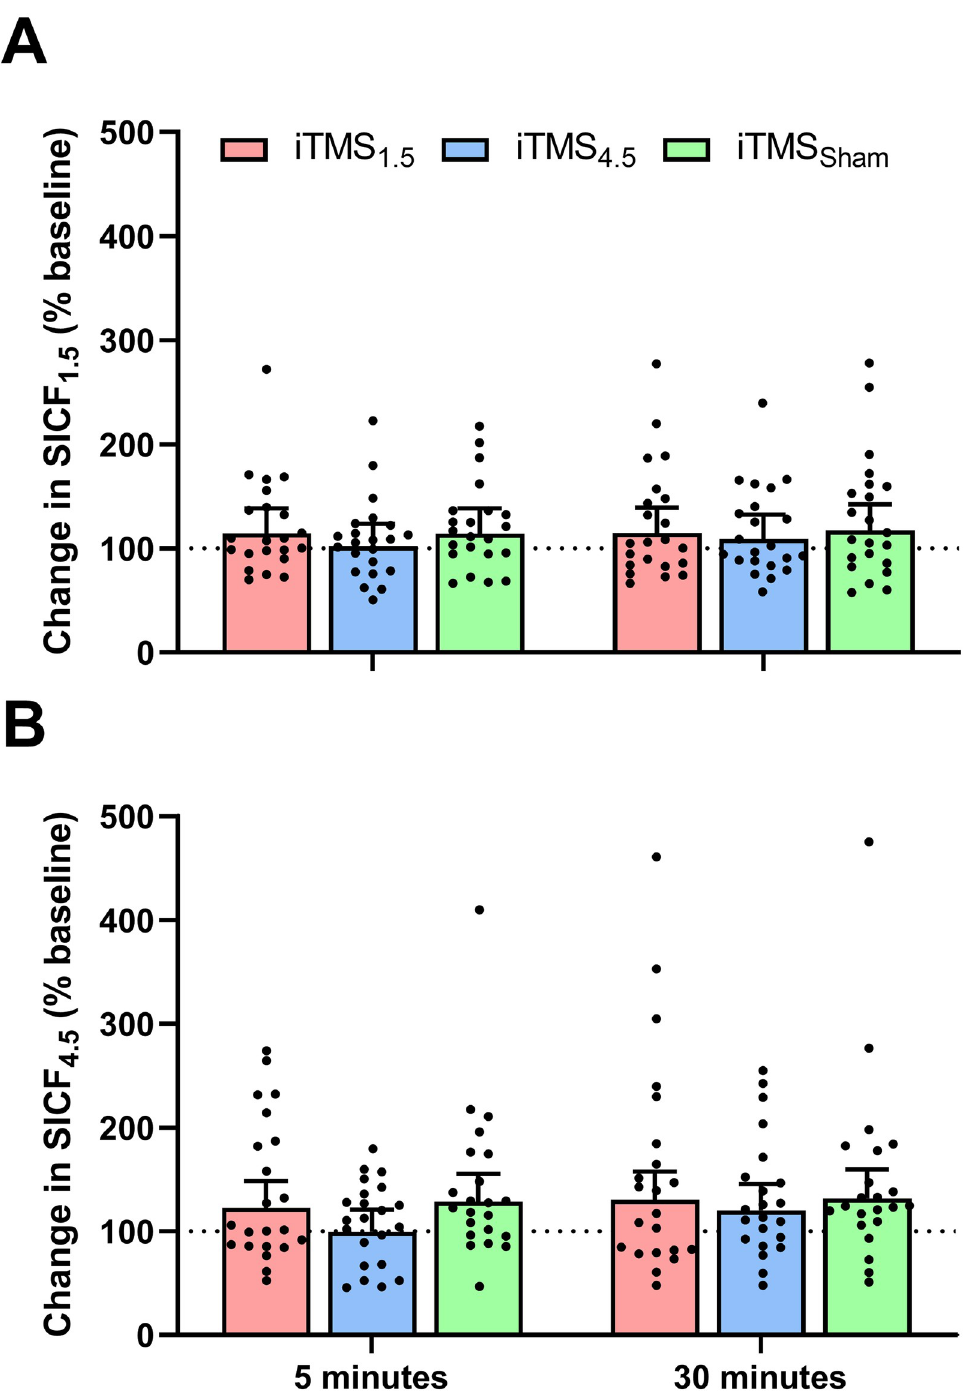
Fig 4. Changes in SICF 1 . 5 (A) and SICF 4 . 5 (B) following iTMS 1 . 5 (red), iTMS 4 . 5 (blue), and iTMS Sham (green) at 5 and 30 minutes.